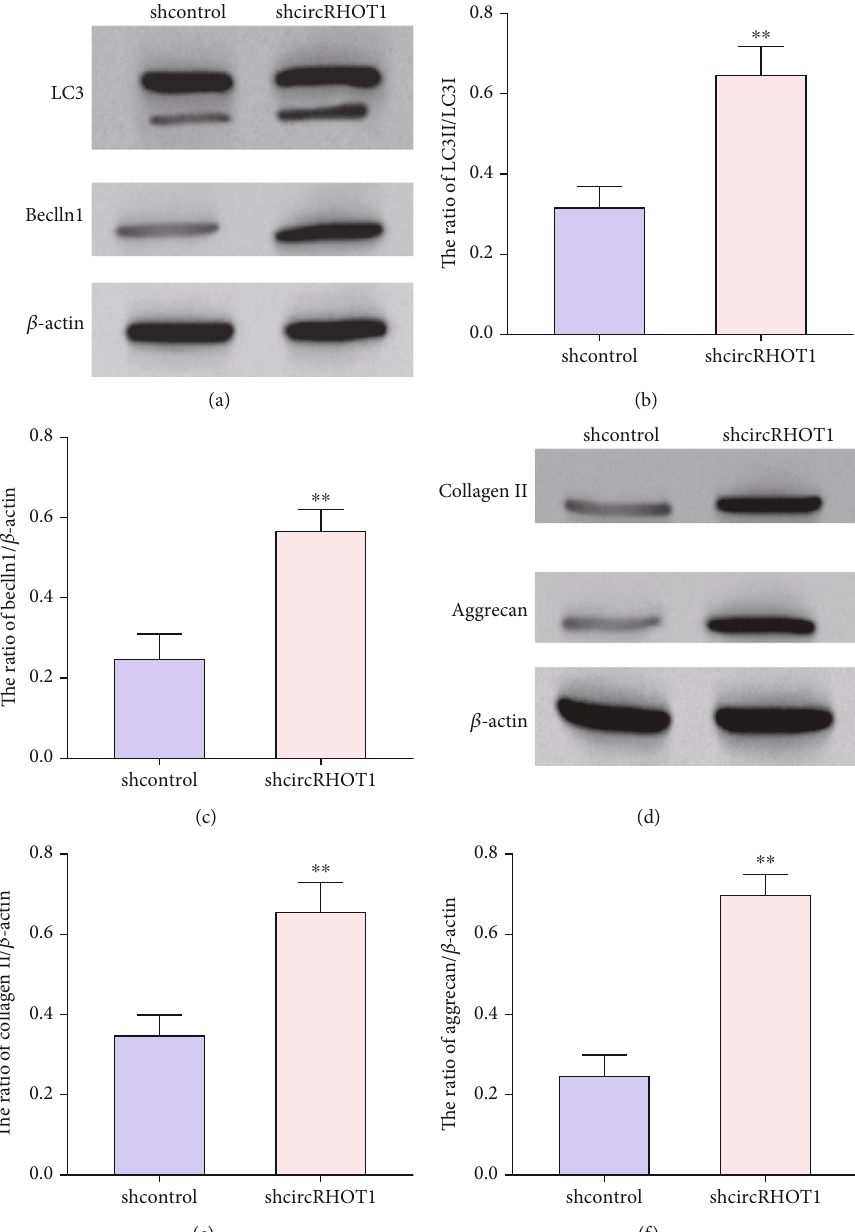
Figure 4: CircRHOT1 represses autophagy and ECM in chondrocytes. (a) – (f) The chondrocytes were treated with circRHOT1 shRNA. (a) – (c) The protein expression of LC3 and beclin1 was detected by Western blot analysis. (d) – (f) The expression of collagen II and aggrecan was analyzed by Western blot analysis. Mean ± SD , ∗∗ P < 0 : 01